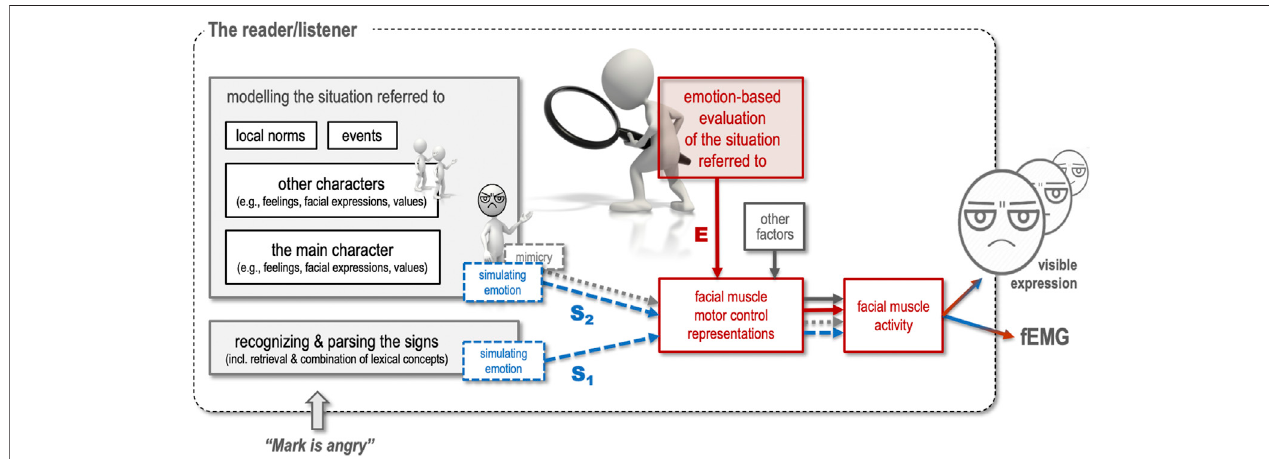
FIGURE 1 | A multiple-drivers model of emotional facial expressions and the associated EMG effects induced by language in simple (e.g., laboratory) communicative contexts. Apart from language-induced emotion simulation and emotional evaluation, the model also acknowledges mimicry and other factors as potential drivers (see the Discussion). Adapted from the fALC model, a broader model of what drives emotional facial expression during language processing (see van Berkum et al., in press).